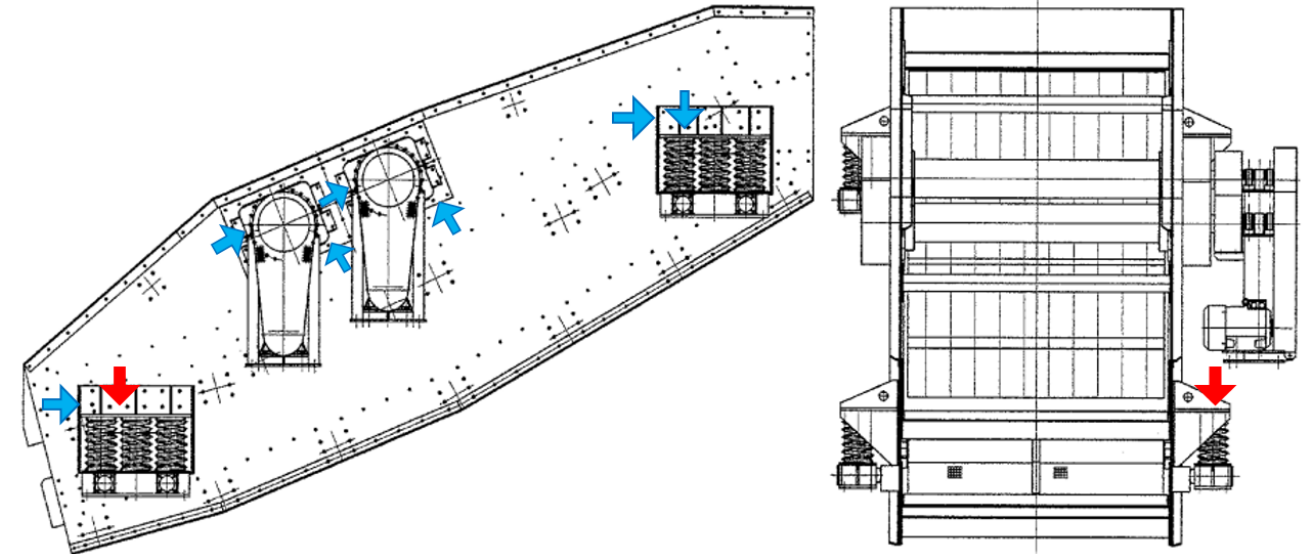
Figure 4. The positions of the vibration sensors used in the measurement session on the vibration screen. The left image presents machine’s left side, however the same sensors with identical configuration in the same positions were installed also on the right side, for the total amount of 16 sensors. The red arrow indicates the position of sensor that registered the signal used for this work, blue arrows indicate the positions of the rest of the sensors. In the right picture (front view) only the one sensor used in this work has been marked for image